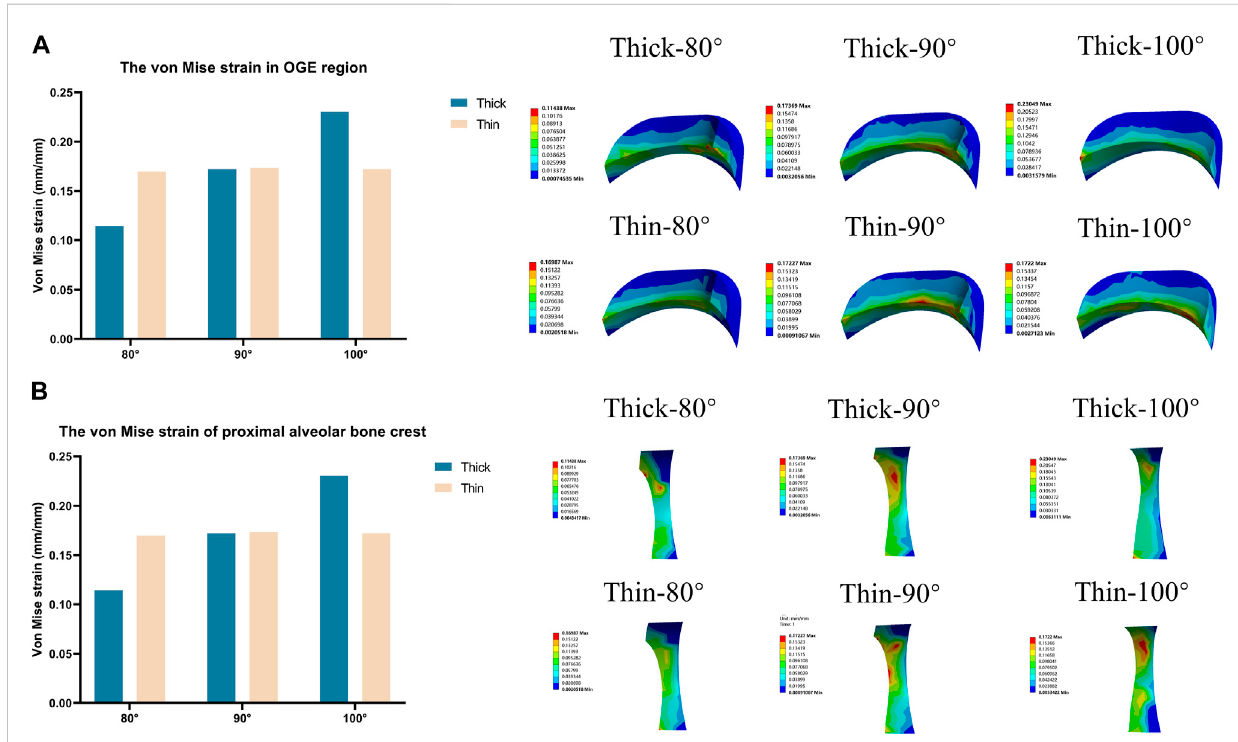
FIGURE 4 VonMisestrainontheOGEregioninvariousmodels(Thick-80 ° ;Thick-90 ° ;Thick-100 ° ;Thin-80 ° ;Thin-90 ° ;Thin-100 ° ). (A) MaximumvonMisestrain in the OGE region, (B) maximum von Mise strain on the proximal alveolar bone